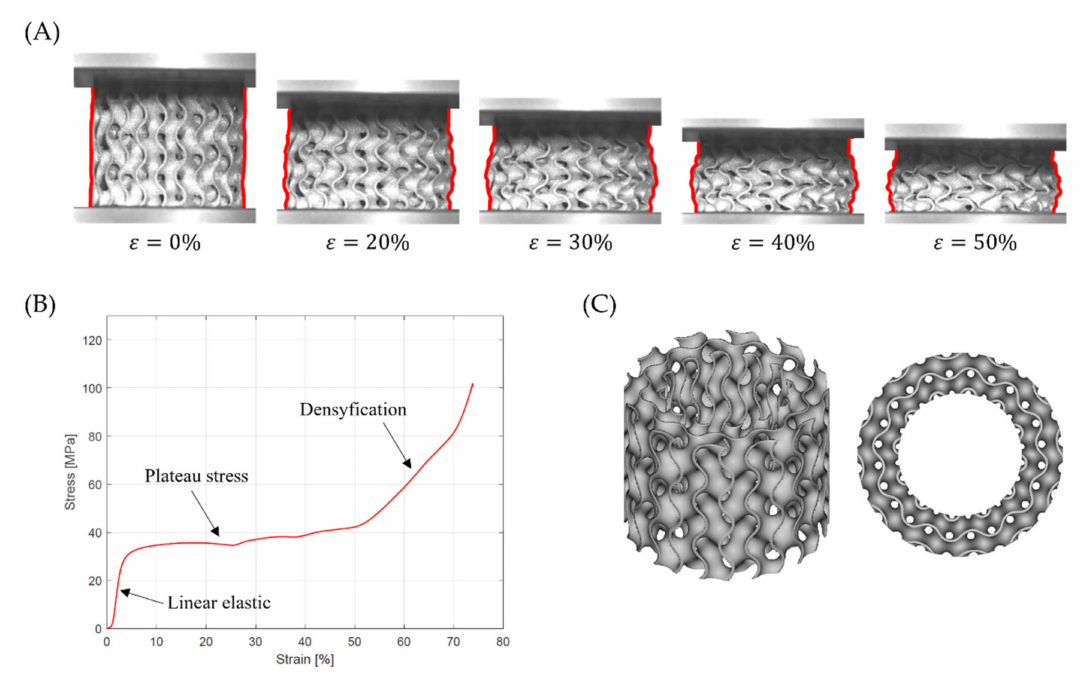
Figure 14. Global uniform deformation mode on the example of a Gyroid_12_1_20_0.70 samples: ( A ) deformation stages in the presence of 0%, 20%, 30%, 40%, 50% strain recorded by ARAMIS measurement system; ( B ) compressive stress–strain curve; ( C ) CAD